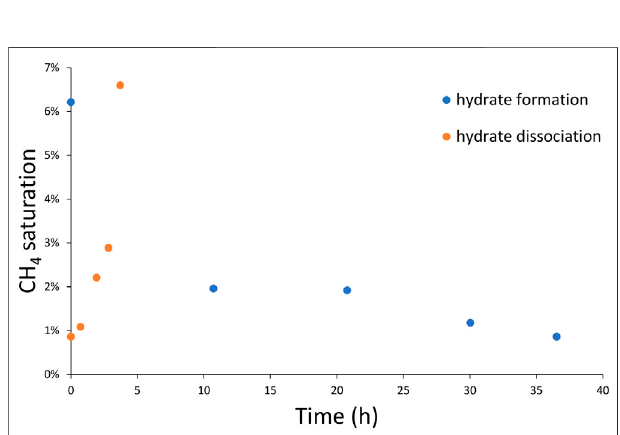
FIGURE 7 | Methane gas consumption and expulsion with time during hydrate formation and dissociation